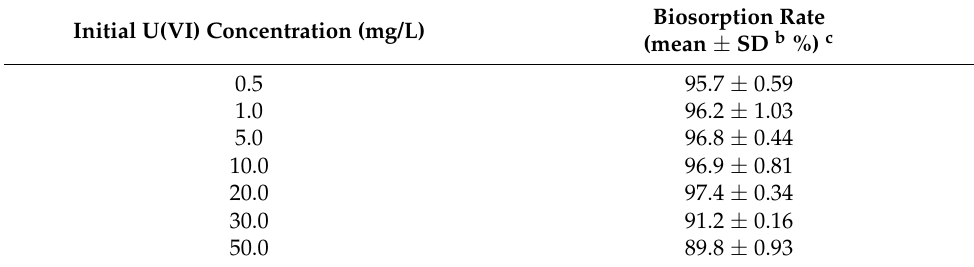
Table 2. Effect of initial U(VI) concentration on biosorption by Parachlorella sp. AA1 cells a .